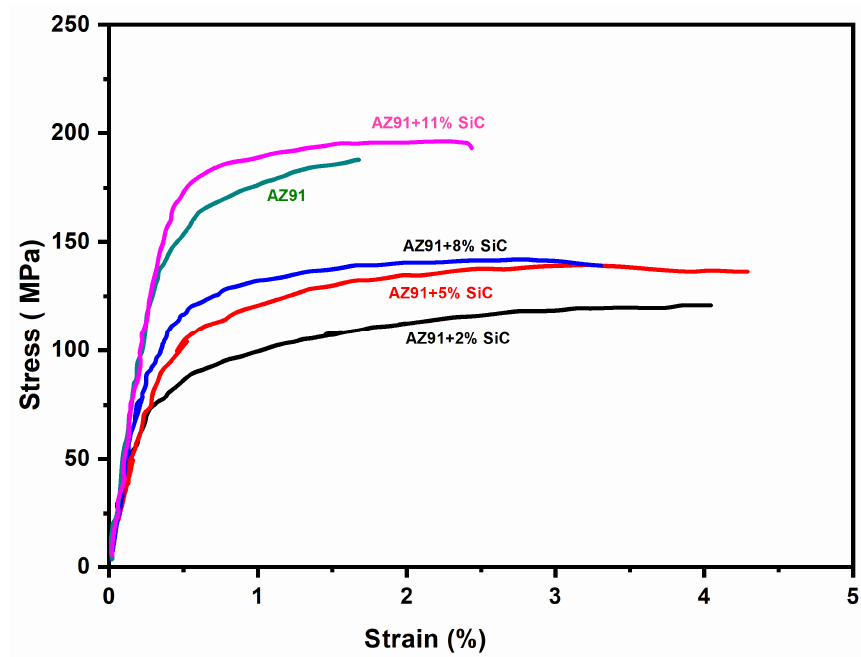
Figure 5. Engineering stress–strain curve of AZ91 and its composites reinforced with SiC particulates.